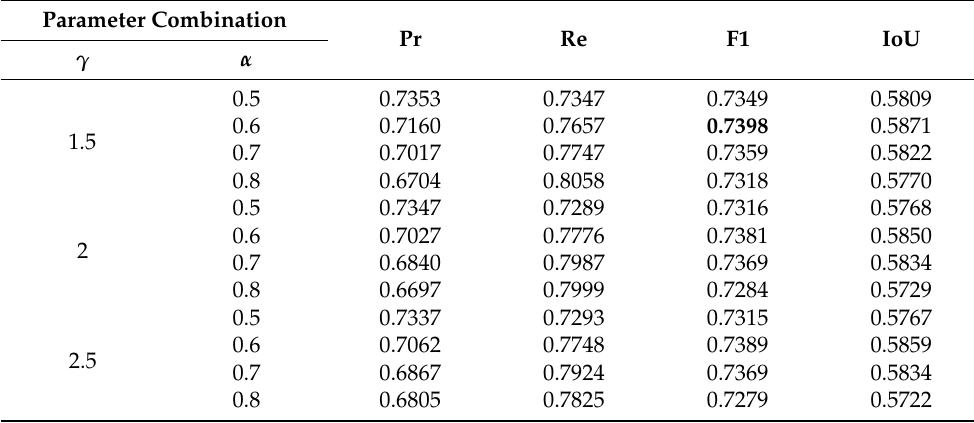
Table 6. The comparison of parameter combinations of focal